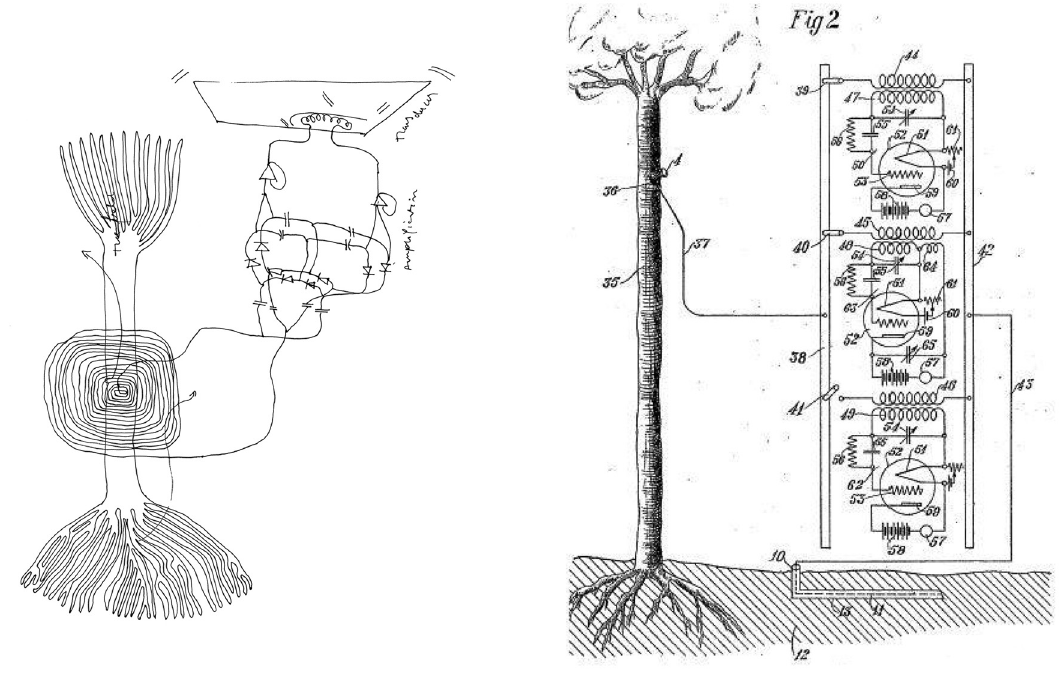
Figure 3: Left: Ioana Vreme Moser, diagram for Arboreal Receptors ( 2021 ) , right: George O. Squier, technical drawing for patent no. US1549032A, Tree Telephony and Telegraphy ,